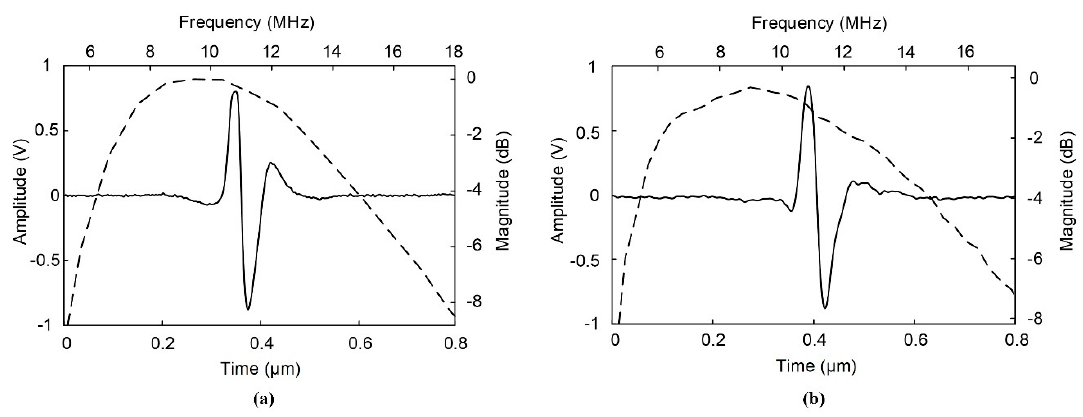
Figure 11. The measured pulse-echo and frequency spectra of transducers after forming a hole of (a) the single focal point transducer and (b) the seven-focal point transducer.